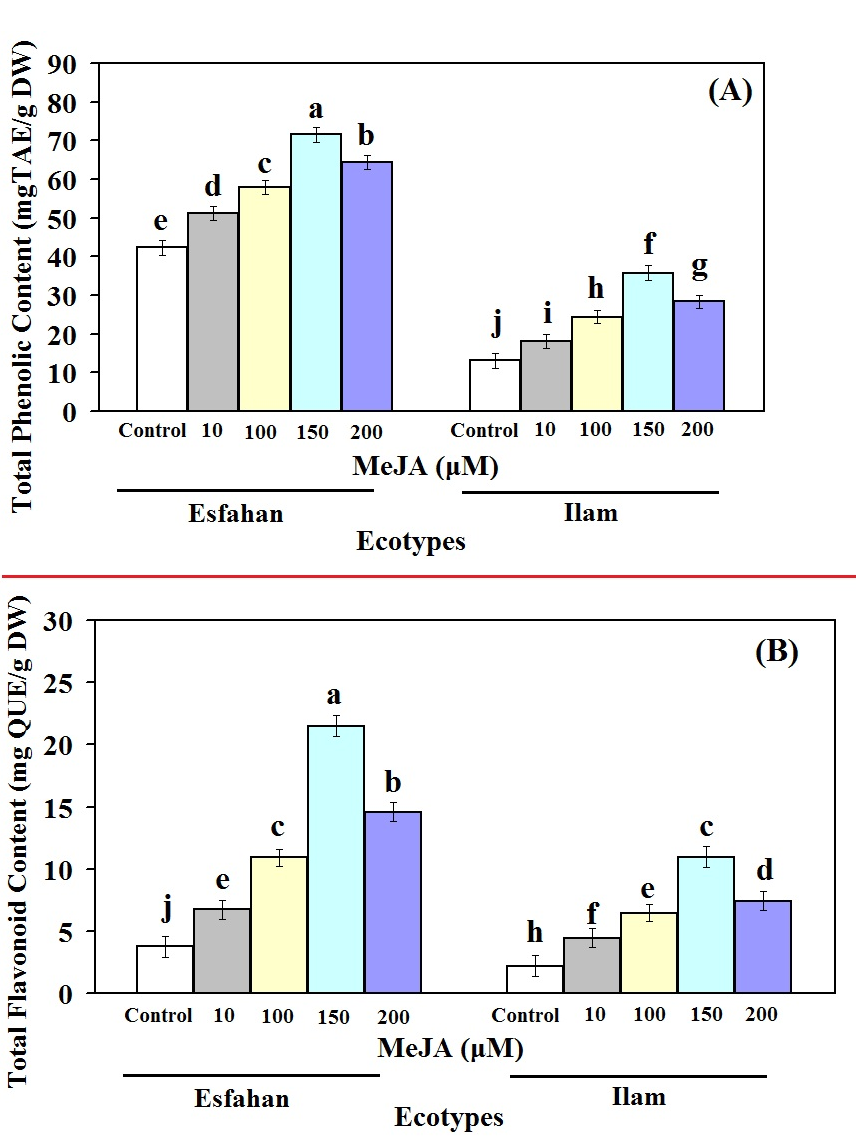
Figure 3. Effect of different concentrations of MeJA on TPC ( A ) and TFC ( B ) of leaf extracts of two Iranian lemon balm ecotypes. The results are expressed as means ± SD ( n = 3). In each column different letters mean significant at 1% level of probability according to Duncan’s test.